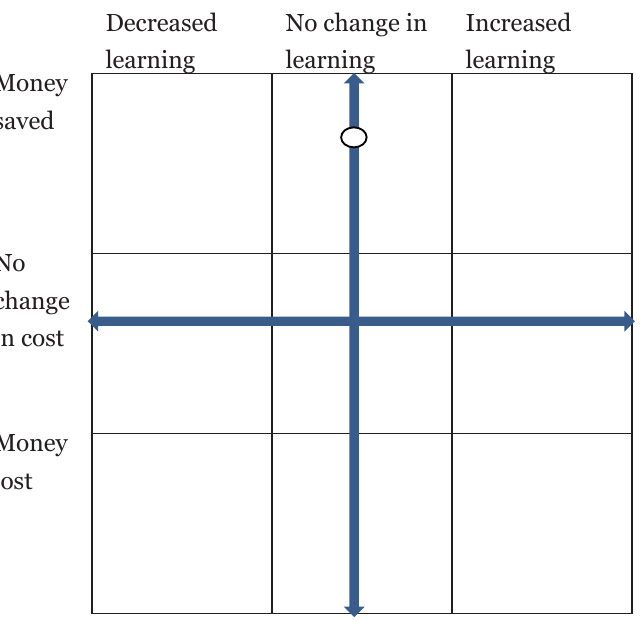
Figure 2. Outcomes in cost and education in the present